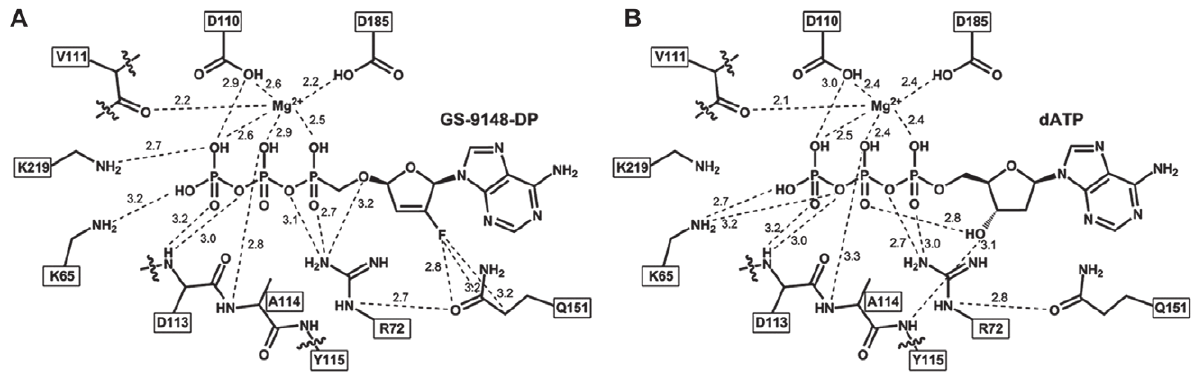
Figure 4 Schematic drawing of (A) GS-9148-DP and (B) dATP occupying the N site of the reverse transcriptase-DNA complex.Hydrogen bonds are shown as dashed lines and corresponding distances in angstroms. Reprinted from Lansdon et al. (18) , copyright 2010, with permission from